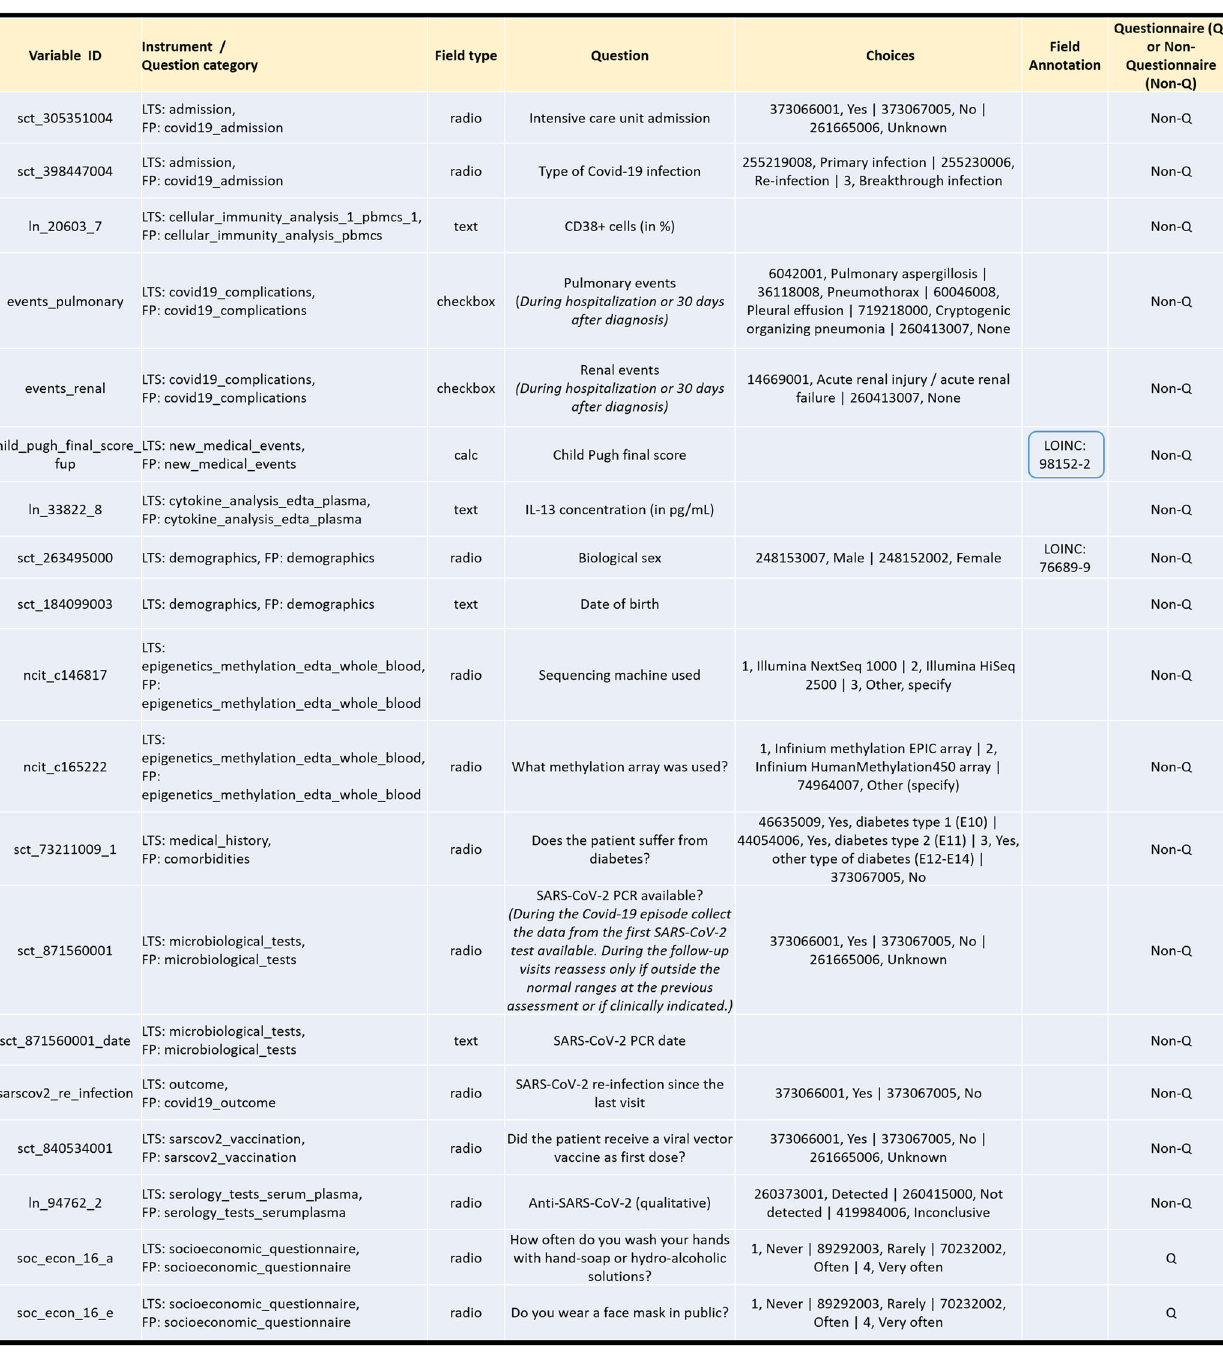
Fig. 2 Excerpt of the Core Data Set. Examples of common elements from the LTS and FP studies. CD38 + cells Cluster of differentiation 38 positive immune cells, IL-13 Interleukin 13, PCR Polymerase chain